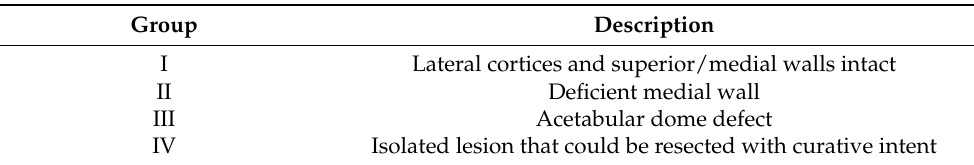
Table 1. Harrington classification describing peri-acetabular metastatic bone disease.